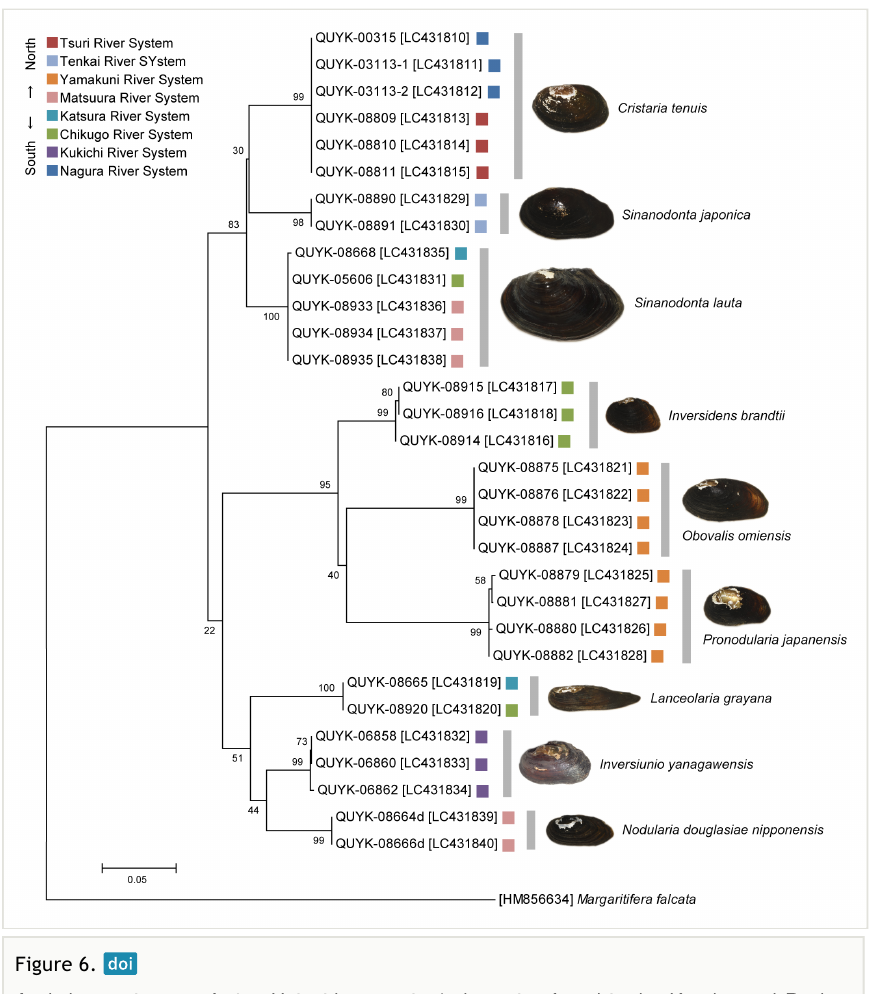
Figure 6. A phylogenetic tree of nine Unionidae species/subspecies found in the Kyushu and Ryukyu Islands (mtDNA 16S-rRNA). The tree was reconstructed using the maximum likelihood method (model: GTR+G) in MEGA 7 (Kumar et al. 2016). Bootstrap values were obtained with 500 pseudoreplicates. Margaritifera falcata was used as an outgroup. The DDBJ accession numbers are shown in